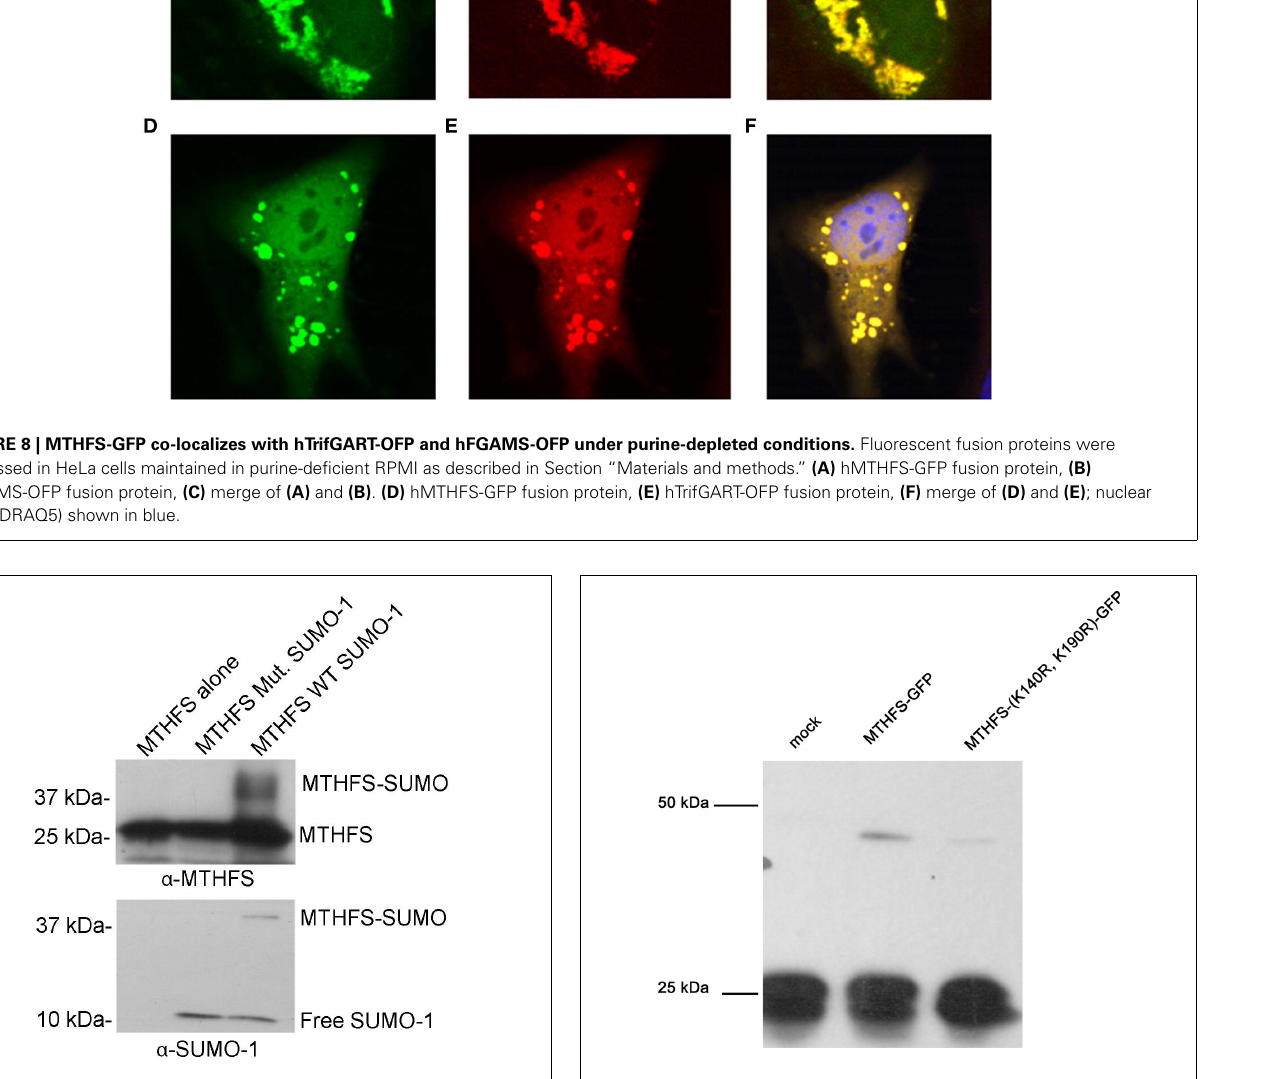
to identify any cells with clustered MTHFS-GFP in the G 2